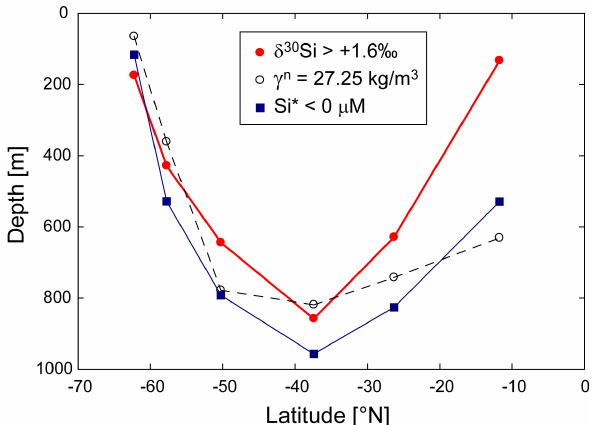
Fig. 4. A comparison of the deepest depth of elevated δ 30 Si values ( > +1.6‰) with the depths of two surfaces that follow the spread- ing of AAIW northwards, showing the strong similarity in evolution with latitude. Both the Si ∗ < 0 and δ 30 Si > +1.6‰ surface shoal more strongly than the isopycnal γ n = 27 . 25kgm − 3 surface in the equatorial Pacific Ocean (12 ◦ S), documenting an additional control on [Si] and δ 30 Si here, as discussed in Sect.